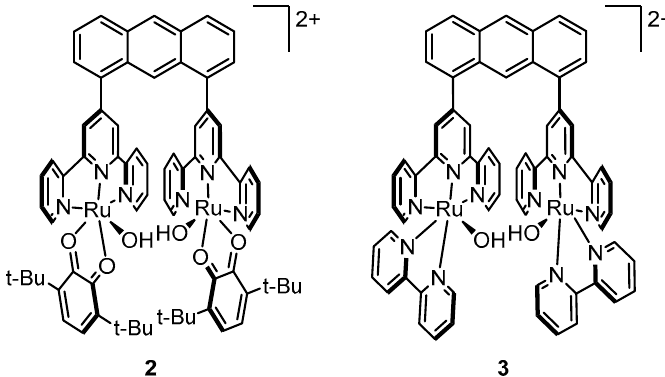
Figure 4. Anthracene-bridged dinuclear ruthenium complexes studied by Tanaka’s group.